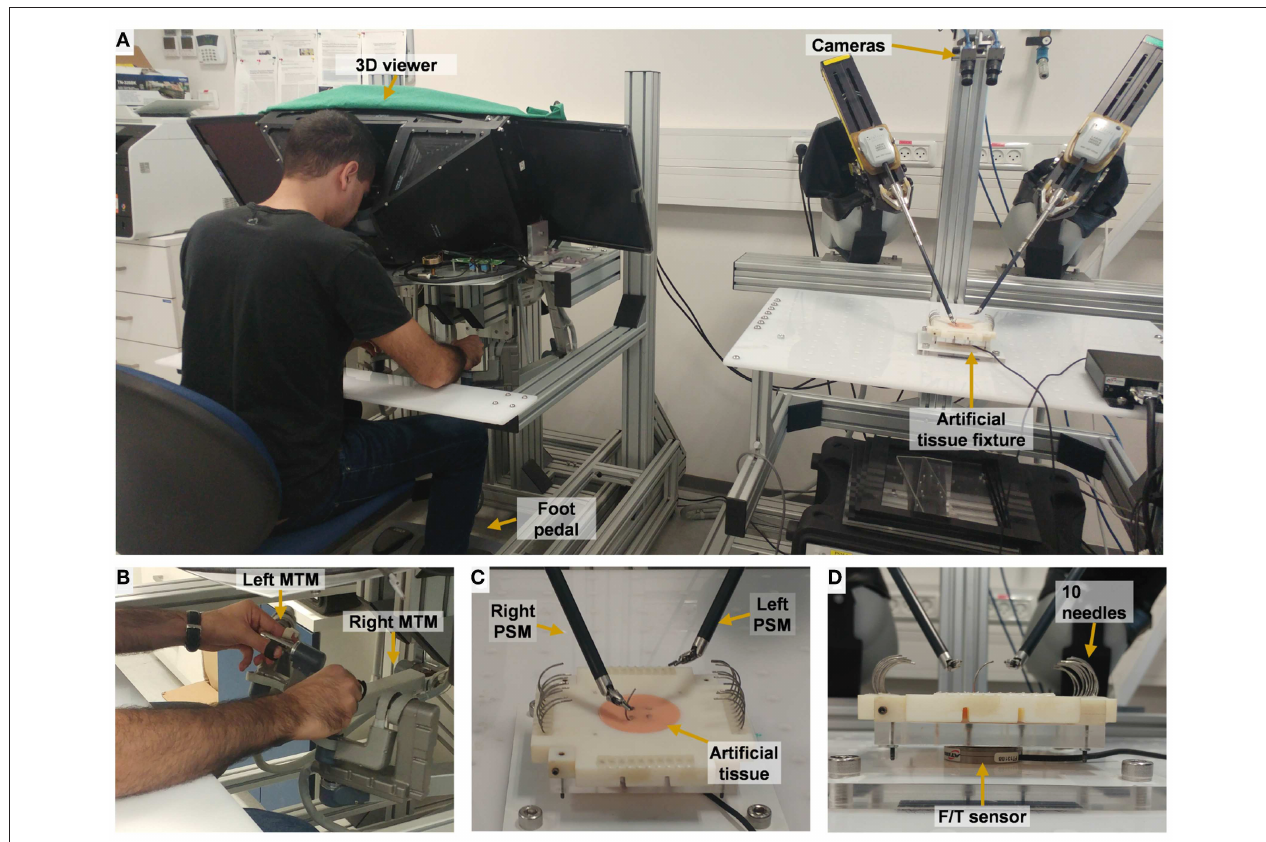
FIGURE 2 | Experimental setup for teleoperation. (A) The participant uses the two dVRK Master Tool Manipulators (MTM) to control the patient side tools. 2 HD cameras are used to acquire the visual information that is presented to the user. (B) Master side: the participant manipulate left MTM and right MTM. (C) Patient side: needle driving is performed on the artificial tissue using the right tool of the patient-side manipulator (PSM). (D) A side view of the artificial tissue fixture. Forces and torques were recorded by the F/T sensor that is embedded in the